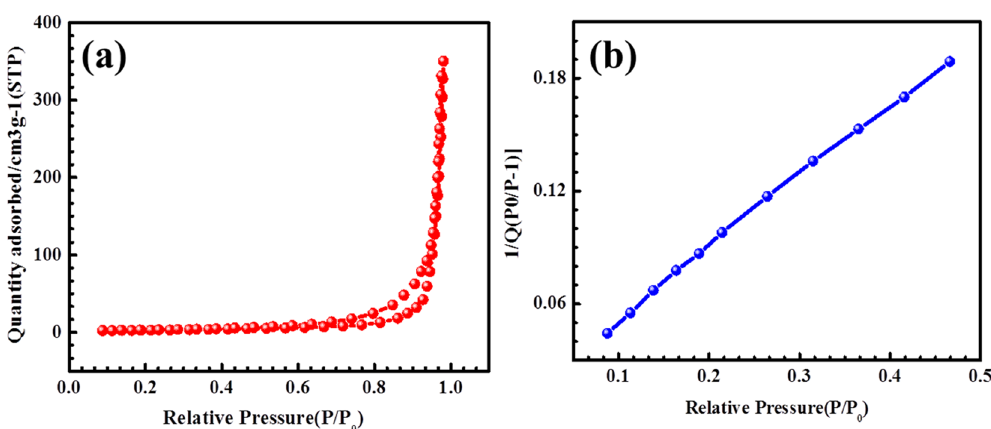
Figure 6. BET analysis of Co 3 O 4 @MnO 2 /NGO